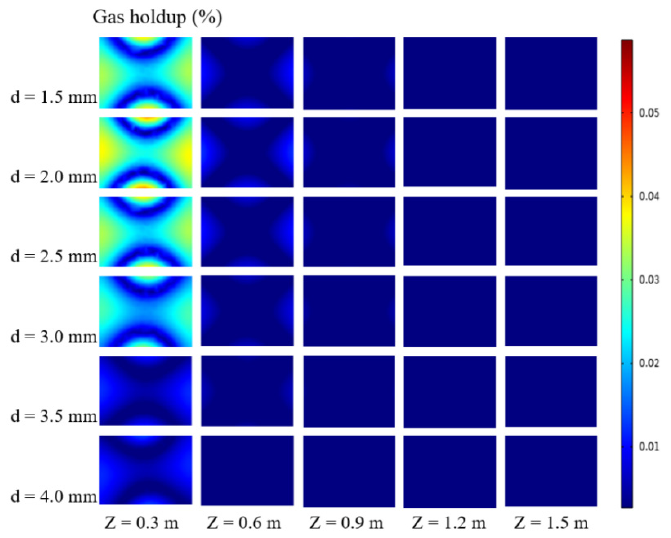
Figure 10. Cloud map of the gas holdup along the horizontal direction at different orifice diame- ters.